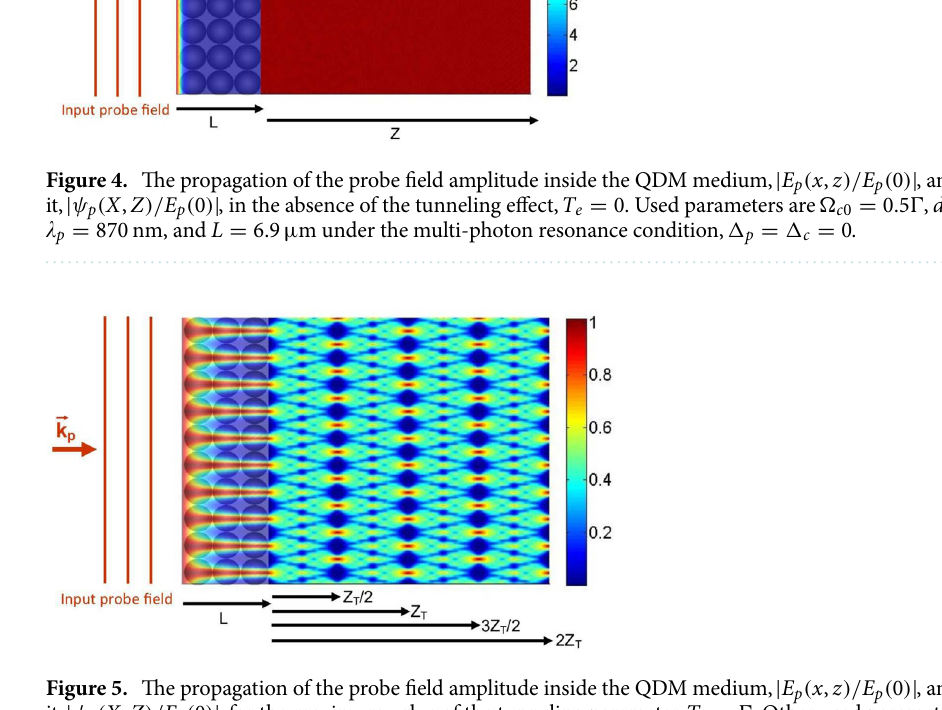
Figure 5. The propagation of the probe field amplitude inside the QDM medium, | E p ( x , z )/ E p ( 0 ) | , and outside it, | ψ p ( X , Z )/ E p ( 0 ) | , for the maximum value of the tunneling parameter, T e = Ŵ . Other used parameters are the same as in Fig.